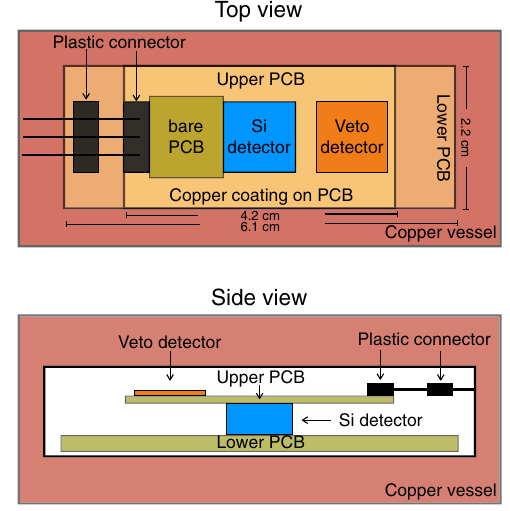
FIG. 17. Schematic depiction of the SuperCDMS HVeV detector module that takes surface data described in Ref. [71]. The active part of the detector is the “ Si detector ” (blue), which is clamped between two printed-circuit boards (PCBs, gray-green) that are partially covered with a layer of copper (two shades of tan color). All surfaces of the two PCBs are coated with copper, except the area denoted as “ bare PCB ” on the front surface of the upper PCB from the top view, as well as the side surfaces. A Si “ veto detector ” is placed on top of the top PCB. Two plastic connectors (black) and a flex cable (not shown) are also located in the copper housing